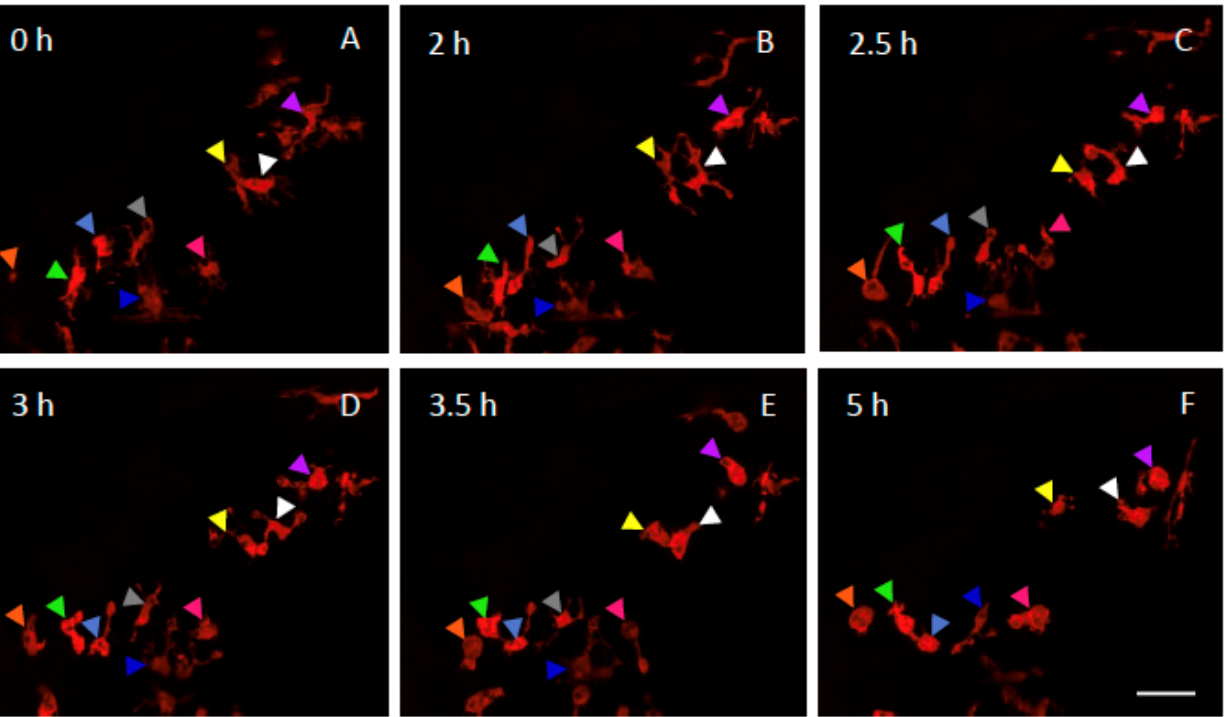
Figure 2. Dynamics of microglia remodelling in DFP-exposed embryos. Selected snapshot views of live imaging of microglia showing the dynamics of microglia morphological changes in a living 5 dpf Tg[mpeg1:mCherryF] larva, before (0 h) and at different time points of a 6 h exposure to 15 µM DFP. Coloured arrowheads indicate individual microglial cells. Scale bar represents 20 µm.